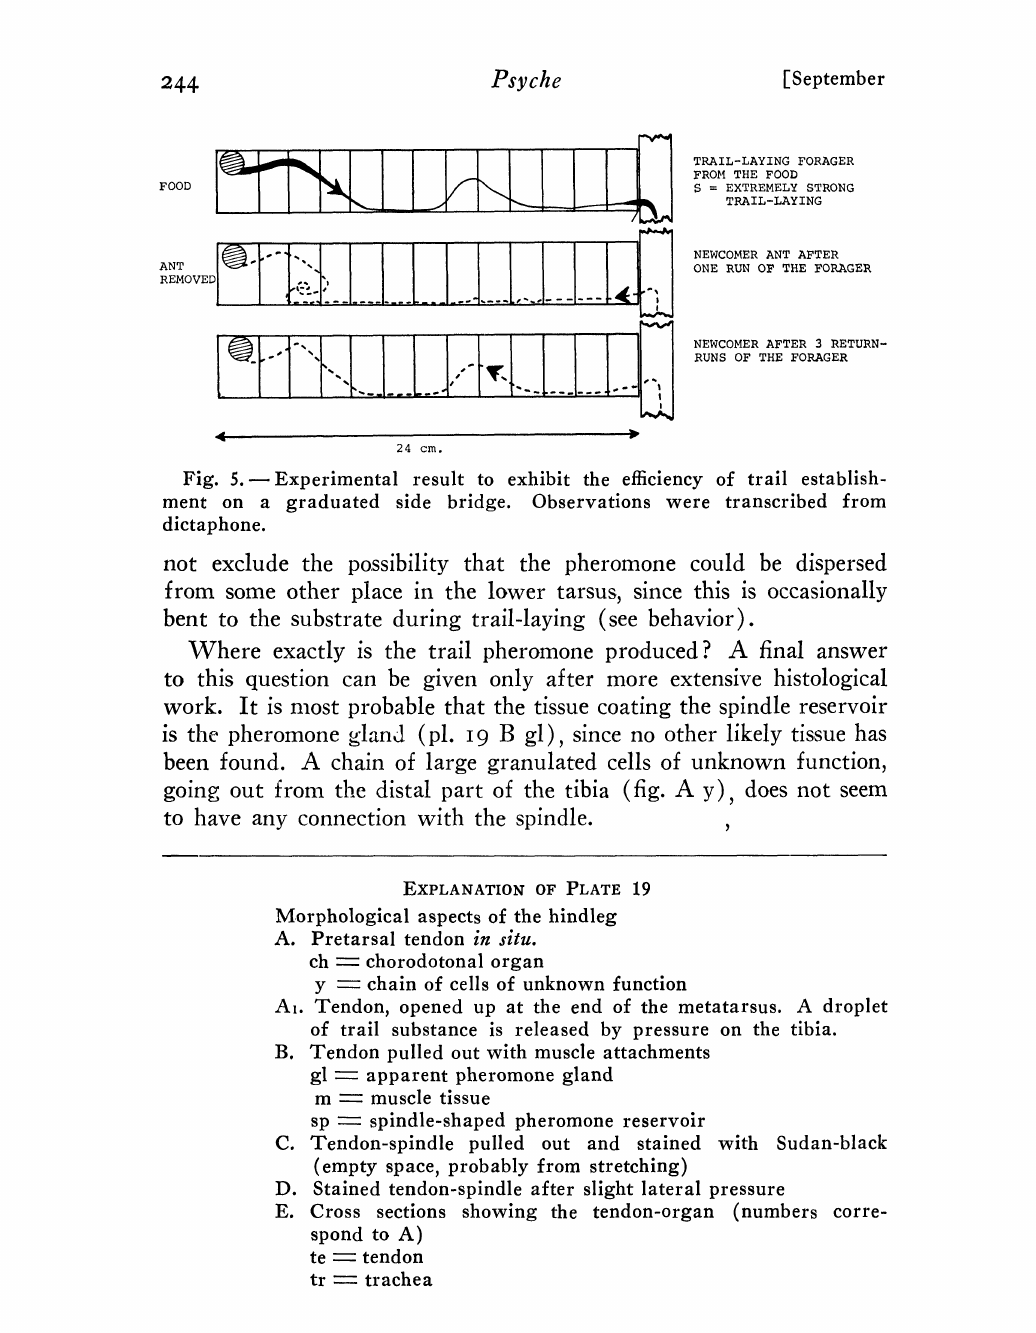
Fig. 5.--Experimental result to exhibit the efficiency of trail establish- ment on a graduated side bridge. Observations were transcribed from